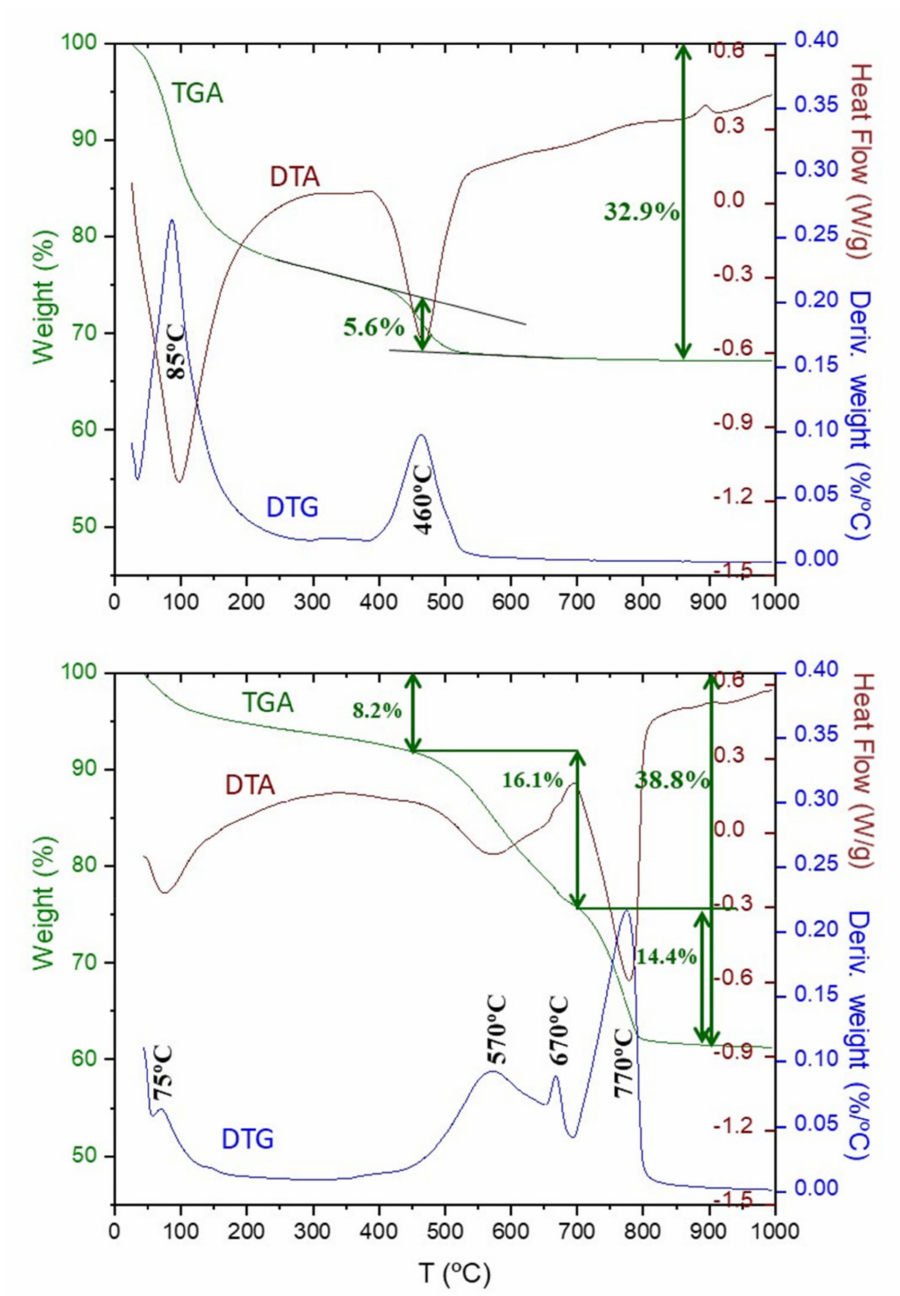
Figure 10. Thermal analysis traces as in Figure 9 for ( a ) C 3 S_hyd and ( b ) C 3 S_carb. For C 3 S_hyd, the reported weight losses 5.6 and 32.9% were calculated from the slope method centred at 460 ◦ C (to correct from the C-S-H contribution at these temperatures) and RT–900 ◦ C, respectively. For C 3 S_carb, the reported weight losses 8.2, 16.1, 14.4 and 38.8% were calculated from the temperature ranges RT–450, 450–700, 700–900 and RT–950 ◦ C, respectively. For C 3 S_carb sample, the first weight loss between RT and ~450 ◦ C, 8.2% is assigned to the water content of the silica gel and the (likely small) fraction of remaining C-S- H gel. Moreover, the presence of a small amount of free water cannot be discarded in this region. In agreement with the Rietveld content where ~0.6 wt% of